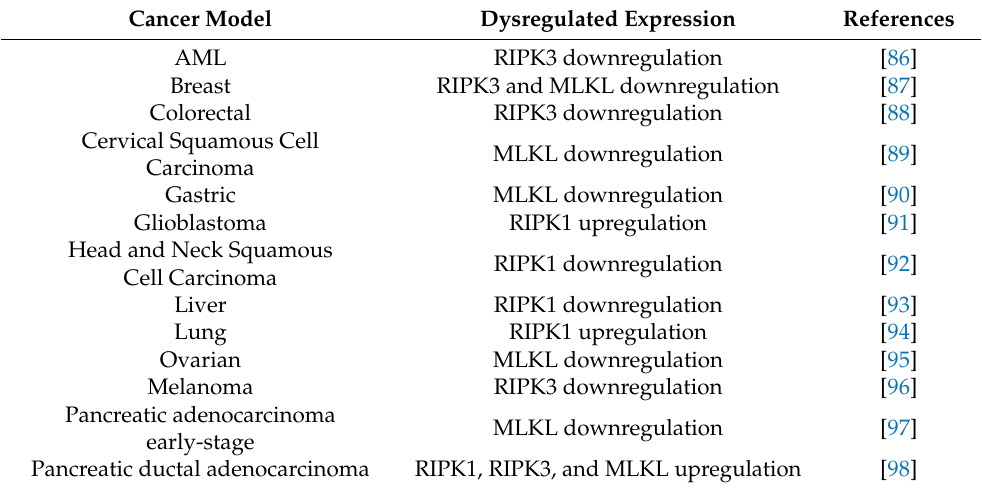
Table 2. Deregulated expression of necroptotic